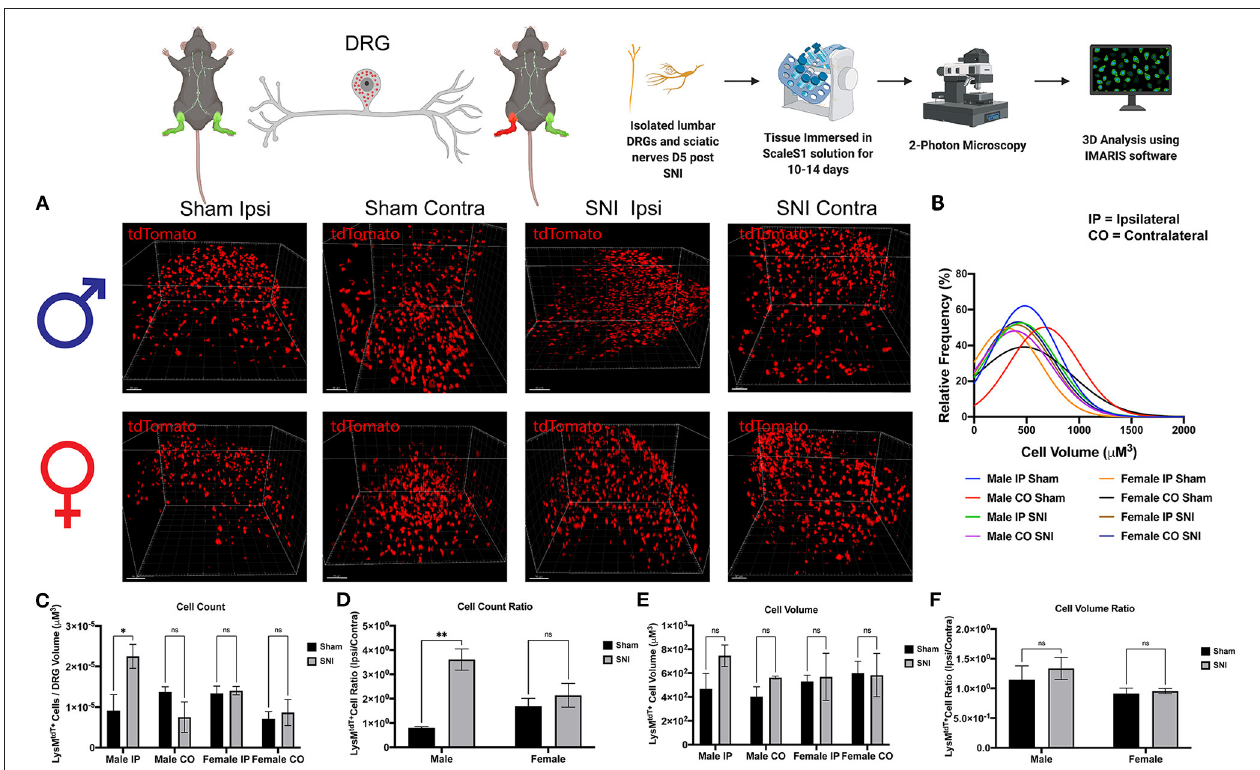
FIGURE 2 | Infiltration of LysM tdT + macrophages in the lumbar DRGs 5 days post-SNI. Male and female LysM tdT + mice had DRGs harvested 5 days post-SNI. Tissues were processed and cleared using ScaleS1 solution for 10–14 days and imaged using 2-photon microscopy. (A) Representative images from male and female LysM tdT + (red; 1,100nm) DRGs ( n = 3). (B) Frequency distribution histogram comparing the frequencies of LysM tdT + cell volumes in control and injured male and female lumbar DRGs. (C) Quantification of LysM tdT + macrophage infiltration in the lumbar DRGs 5 days post-SNI ( n = 3) in males and females. (D) Quantification of LysM tdT + macrophage infiltration in the lumbar DRGs 5 days post-SNI as a ratio of ipsilateral over contralateral DRG ( n = 3) in males and females. (E) Quantification of LysM tdT + macrophage volume in the lumbar DRGs 5 days post-SNI ( n = 3) in males and females. (F) Quantification of LysM tdT + macrophage cell volumes in the lumbar DRGs 5 days post-SNI as a ratio of ipsilateral over contralateral DRG ( n = 3) in males and females. * p < 0.05; ** p < 0.01. Scale Bar: 100 µ m. IP, Ipsilateral; CO, Contralateral. Made using